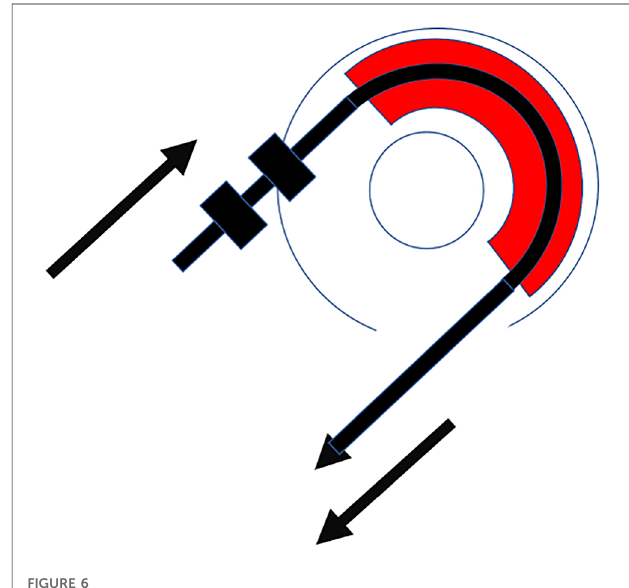
FIGURE 5 First silicone ring is visible in the cochleostomy.